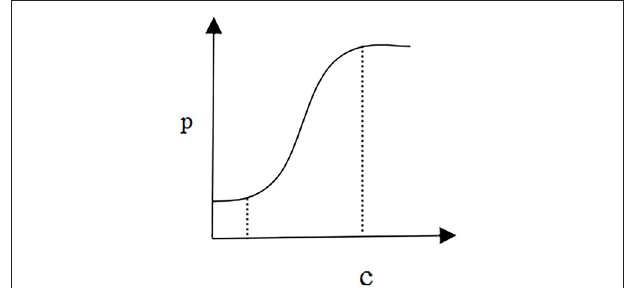
FIGURE 1 | Price and PED.